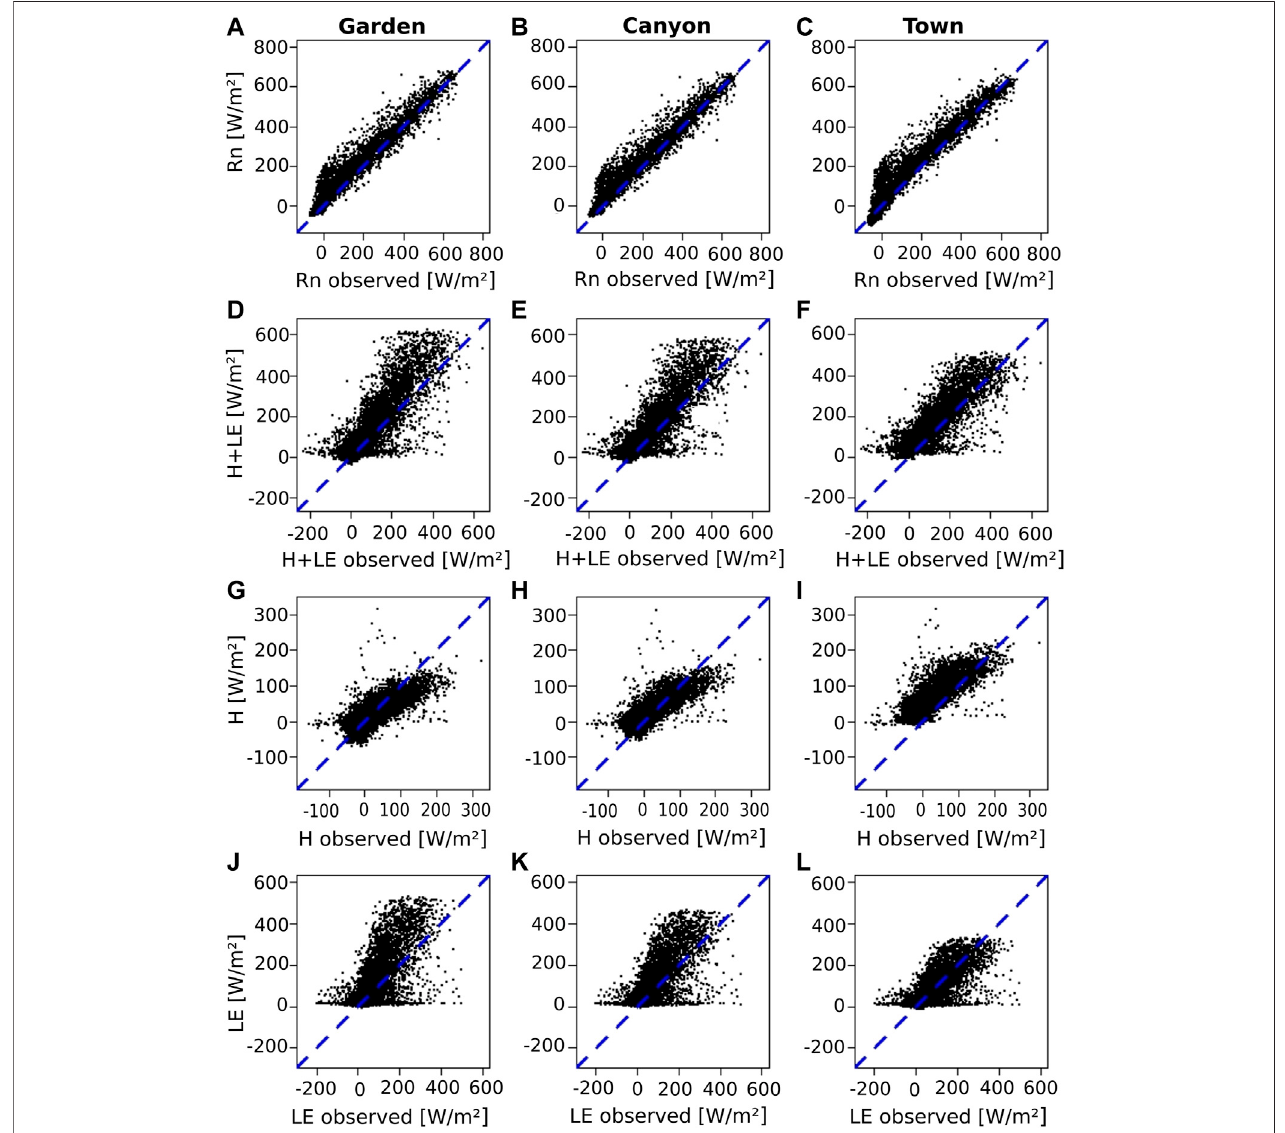
FIGURE 5 | Comparison of measured and modelled (A – C) net radiation (Rn), (D – F) total conductive heat fl uxes (H + LE), (G – I) sensible heat fl uxes (H), and (J – L) latent heat fl uxes (LE) modelled at the garden ( fi rst column), canyon (second column) and town (third column) scales.